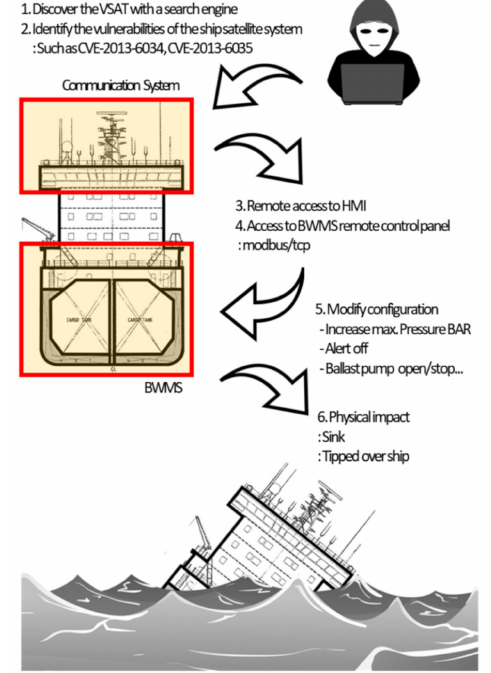
Figure 4. Scenario of attack case 2.